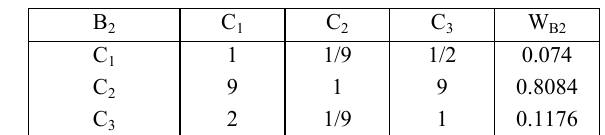
Table 3. The pairwise comparison matrix C 1-3 –B 2